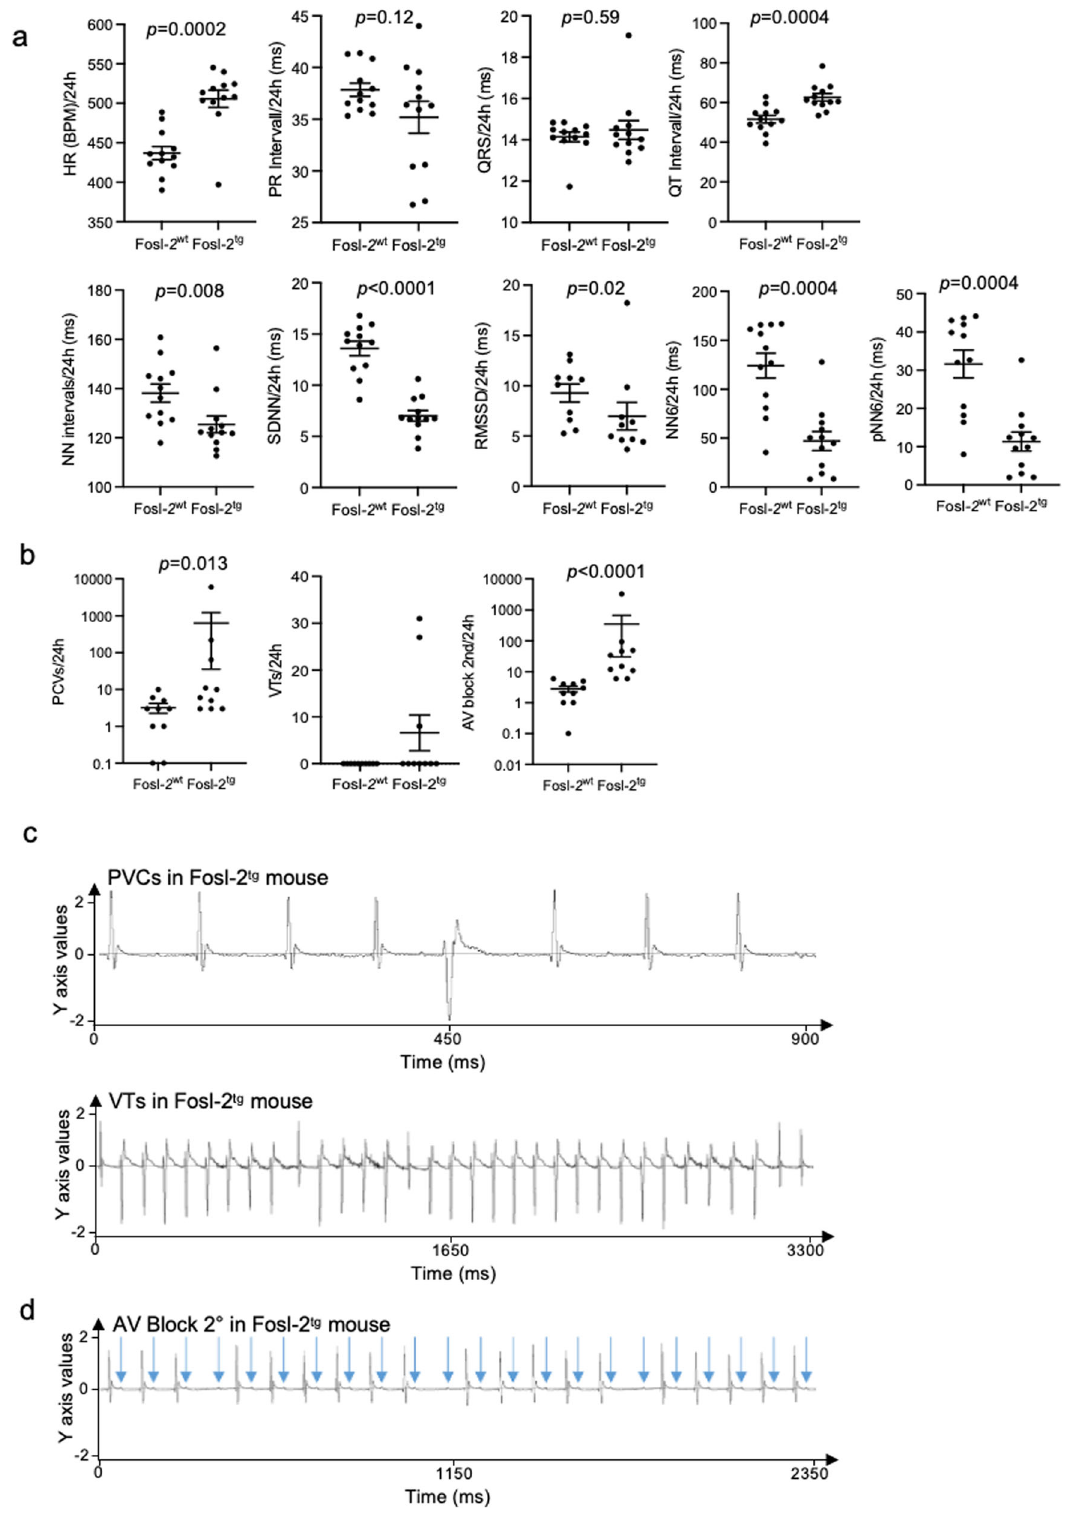
Fig. 2 Fosl-2 tg mice show changes in ECG and in parasympathetic/sympathetic balance. a Representative pictures of radiotelemetry ECG parameters and the heart rate variability parameters recorded within 24h in Fosl-2 wt and Fosl-2 tg mice at week 16 – 22 ( n = 12; unpaired t -test, mean±SEM). b Analyses of PVC and VT events and AV blocks second-degree assessed by radiotelemetry and calculated as the average of 24h of continuous ECG recording in awake Fosl-2 wt and Fosl-2 tg mice ( n = 10, unpaired t -test, mean±SEM). c Representative radiotelemetry ECG pictures of PVCs and VTs in Fosl-2 tg mouse. d AV block second-degree and representative pictures of AV blocks in Fosl-2 tg mouse. Arrows indicate P waves. HR heart rate, BPM beatings per minute, PVCs premature ventricular contractions, VTs ventricular tachycardias, AV block atrio-ventricular block, SDNN standard deviation of all NN intervals, RMSSD the square root of the root mean square of the sum of all differences between successive NN intervals, NN intervals interval between two normal heartbeats.